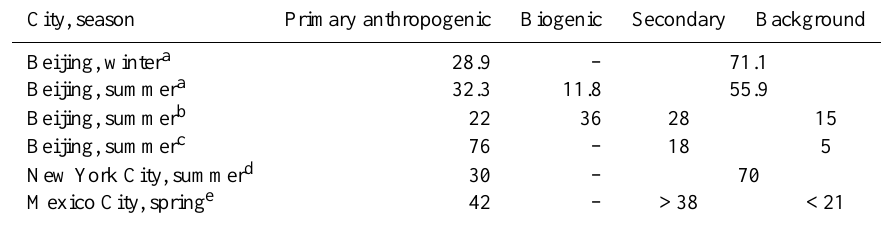
Table 3. Comparison of source apportionment results of ambient formaldehyde obtained in this study with previous studies.